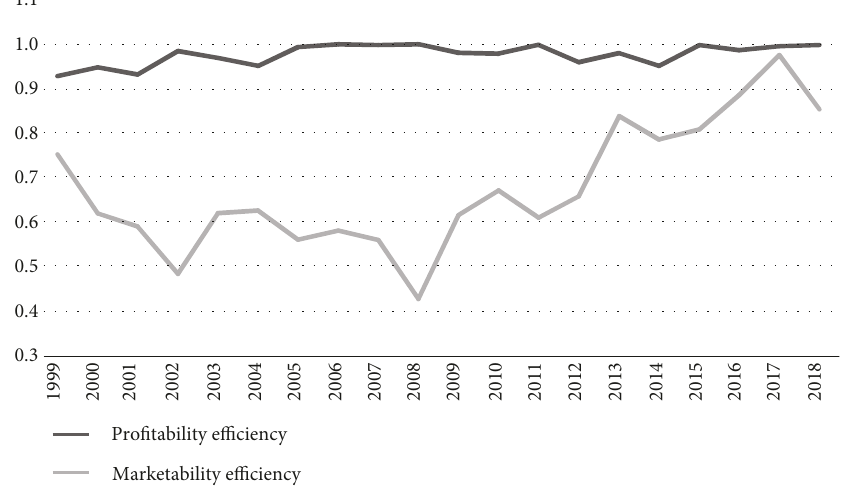
Figure 2: Trends of firm